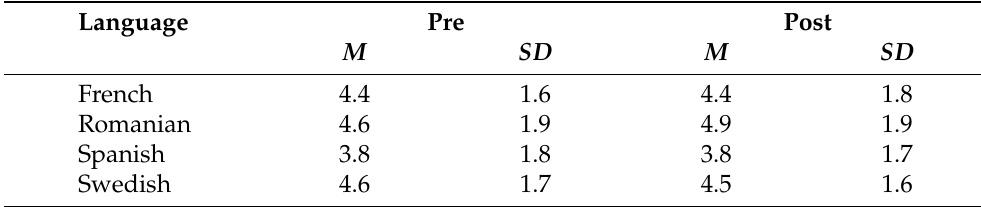
Table A9. I confront my impressions with friends and peers.